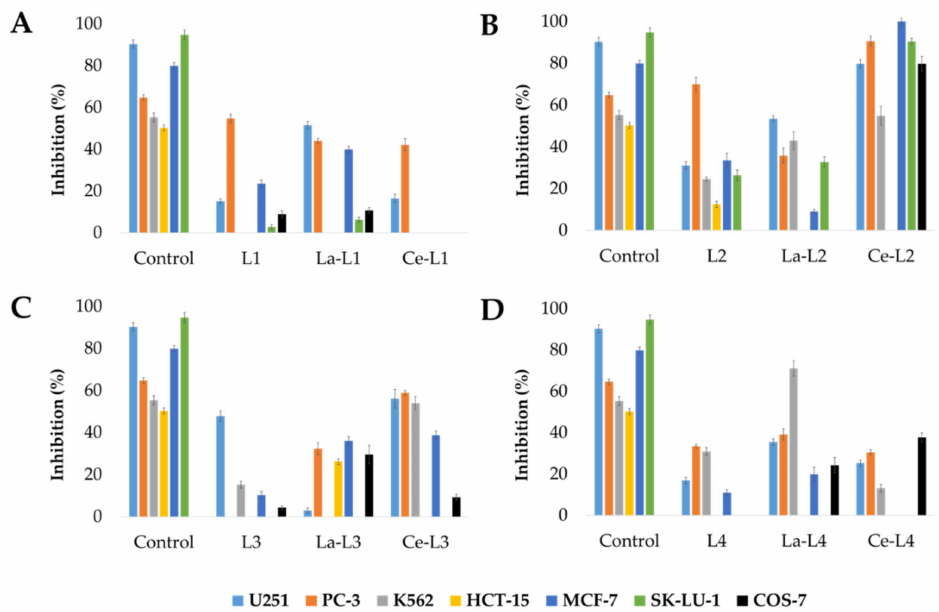
Figure 1. Inhibition growth (%) of different human cancer cell lines at 25 µ M for ( A ) L1 series, ( B ) L2 series, ( C ) L3 series, and ( D ) L4 series; control = cisplatin. (Missing bars mean no activity was